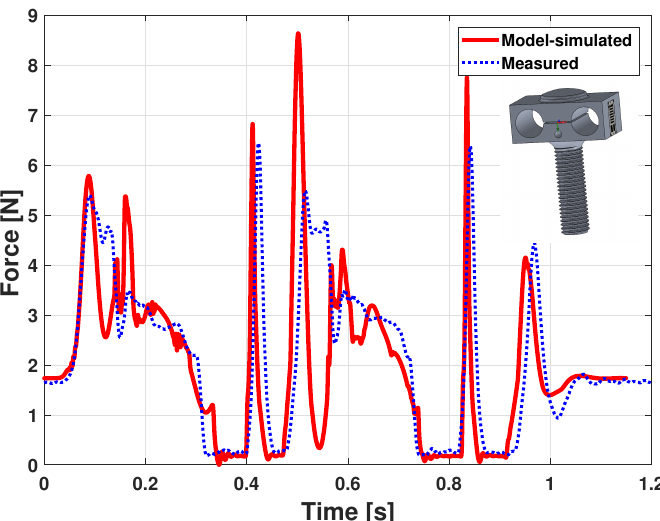
Figure 17. Piano action model dynamic validation: force (fast double